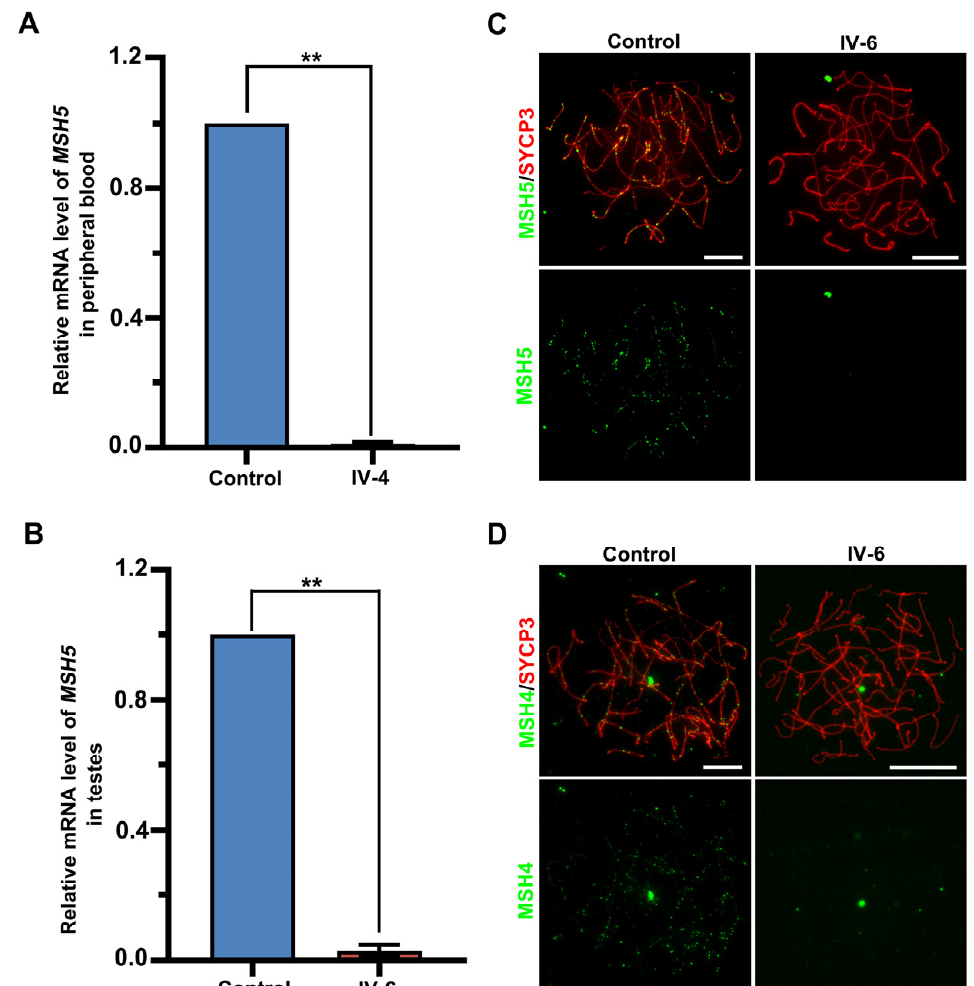
Figure 4. The effects of the MSH5 mutation on MSH5 expression and MSH4 loading. ( A , B ) Quantitative PCR analyses of the relative MSH5 expression in the blood samples ( A ) from the control and IV-4, and testicular samples ( B ) from the control and IV-6. ACTB served as an internal control. Data were obtained from two experiments and presented as mean ± SD. ** p < 0.01. Statistical significance is determined using the two-tailed t test. ( C , D ) Representative images of surface-spread spermatocytes from the control and IV-6 stained with antibodies against SYCP3 (red) and MSH5 (green) ( C ) or MSH4 ( D ). Scale bars, 10 µ